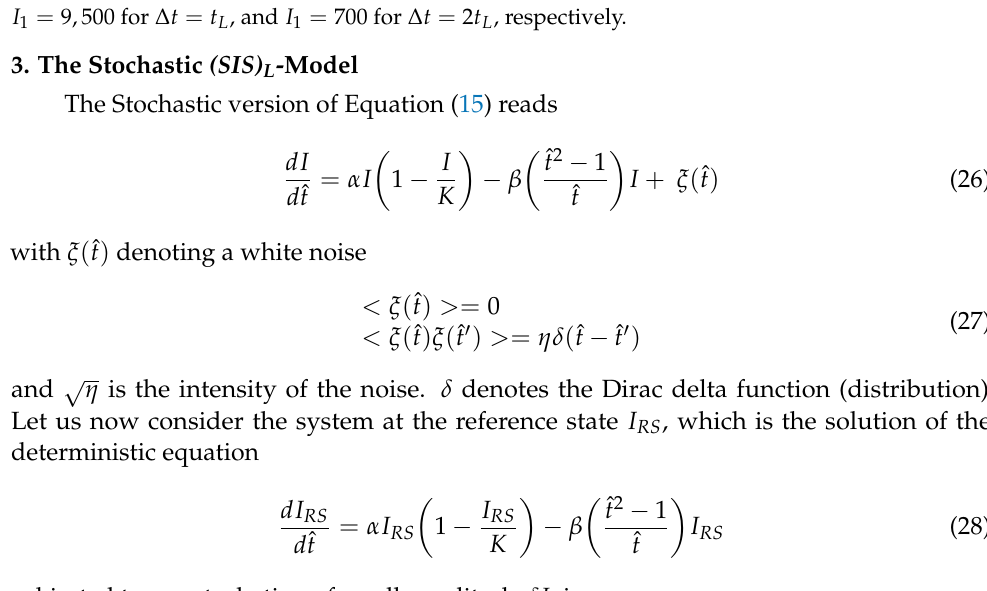
Figure 4. As shown in the figure, setting the value of ˜ I = 50,000, the maximum value of I 1 is I 1 = 9,500 for ∆ t = t L , and I 1 = 700 for ∆ t = 2 t L ,